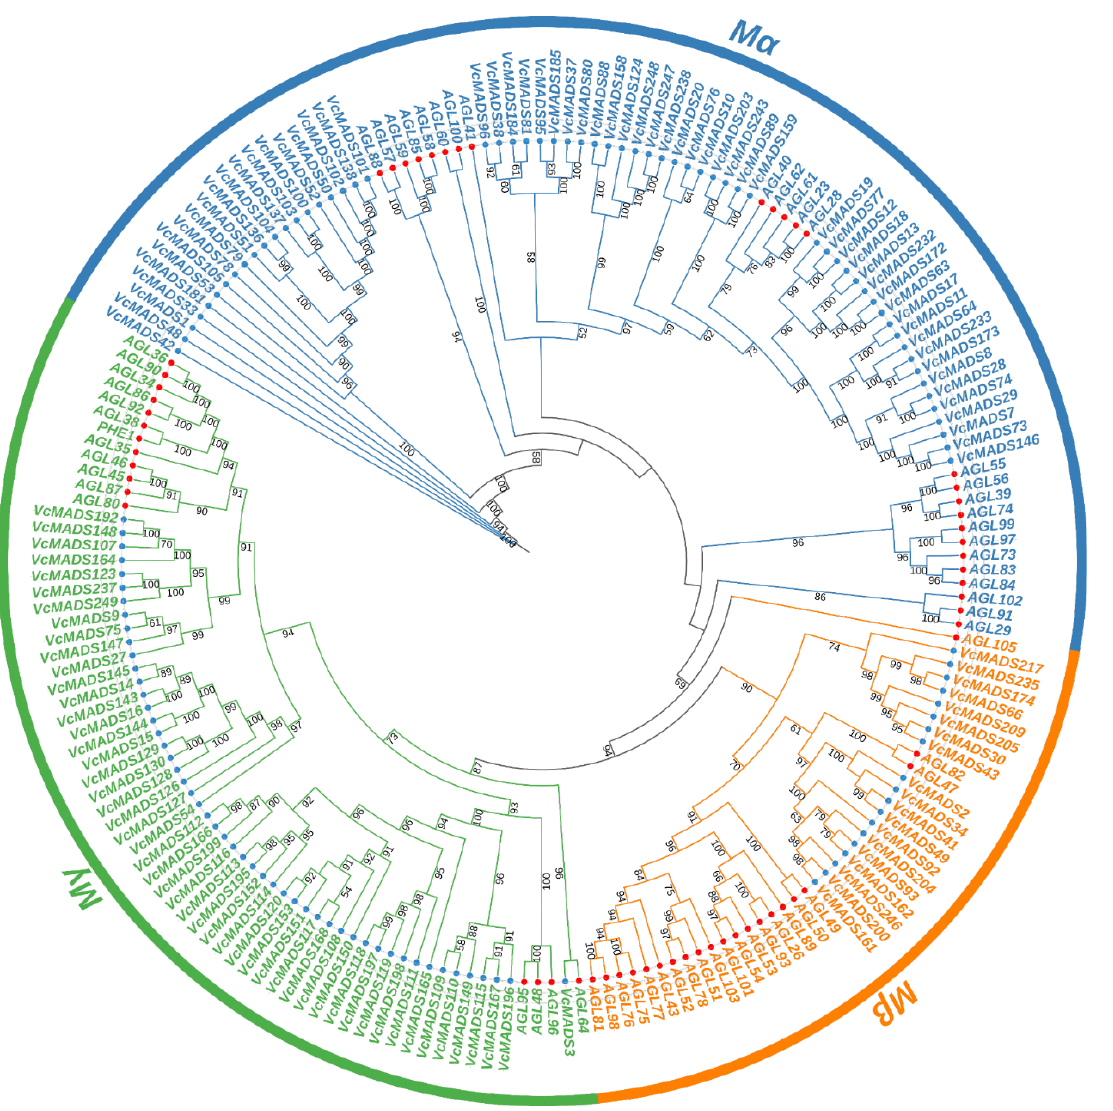
Figure 1. Phylogenetic tree of type I (M-type) MADS-box proteins from blueberry and Arabidopsis. MADS-box proteins of blueberry and Arabidopsis are marked with blue and red circles, respectively. The digits on the branches represent bootstrap values for 1000 replicates.